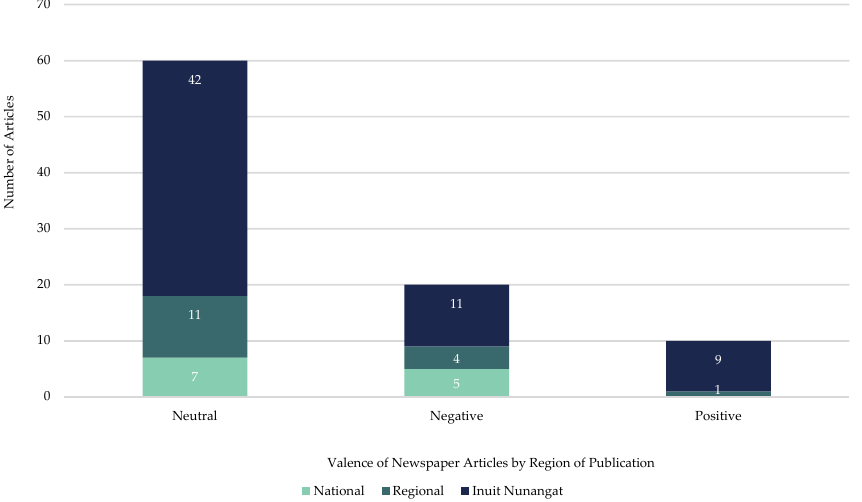
Figure 5. Breakdown of overall valence, by region of publication, of included articles on mining industry’s initial response to COVID-19 in Inuit Nunangat from 1 January 2020, to 30 June 2020. In contrast, 22% (n = 20 articles) of total articles included an overall negative valence.